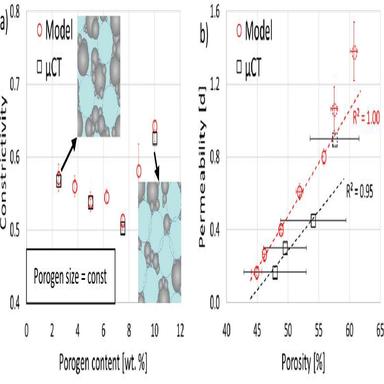
Constrictivity a), and permeability b) results for studied samples.